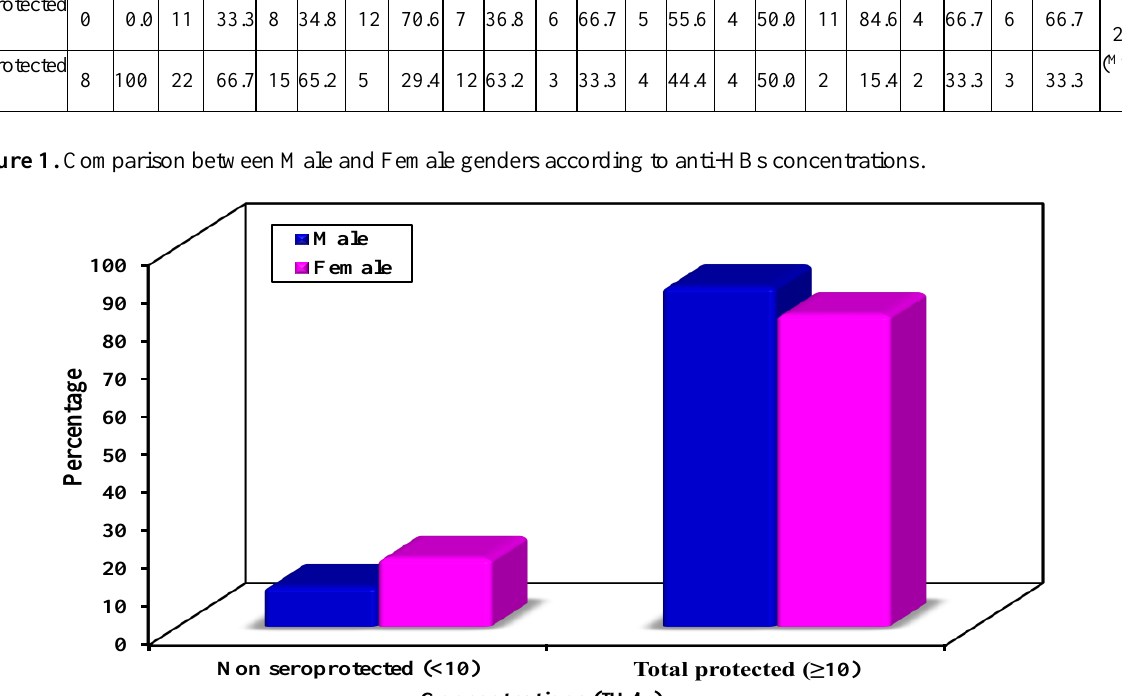
Figure 2. Comparison between male and female genders according to levels of seroprotection